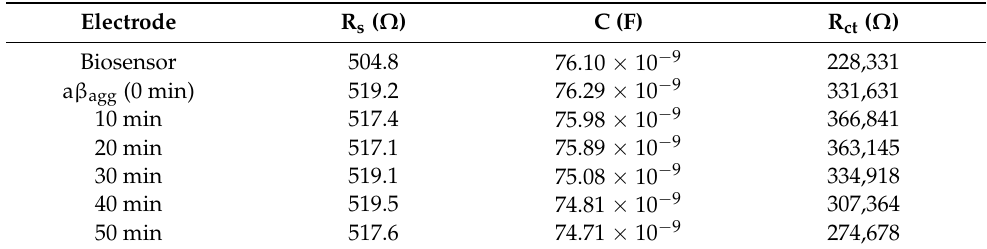
Figure 8. ( a ) Disaggregation mechanism of a β agg by EPPS, and ( b ) the impact of EPPS on a β pep . Table 3. EIS parameters of the anti-a β /SAM/ICE biosensor after incubating with a β agg , and then conduct to treatment with EPPS at different time intervals, extrapolated by fitting the measured spectra in Figure 7a to the equivalent circuit model of